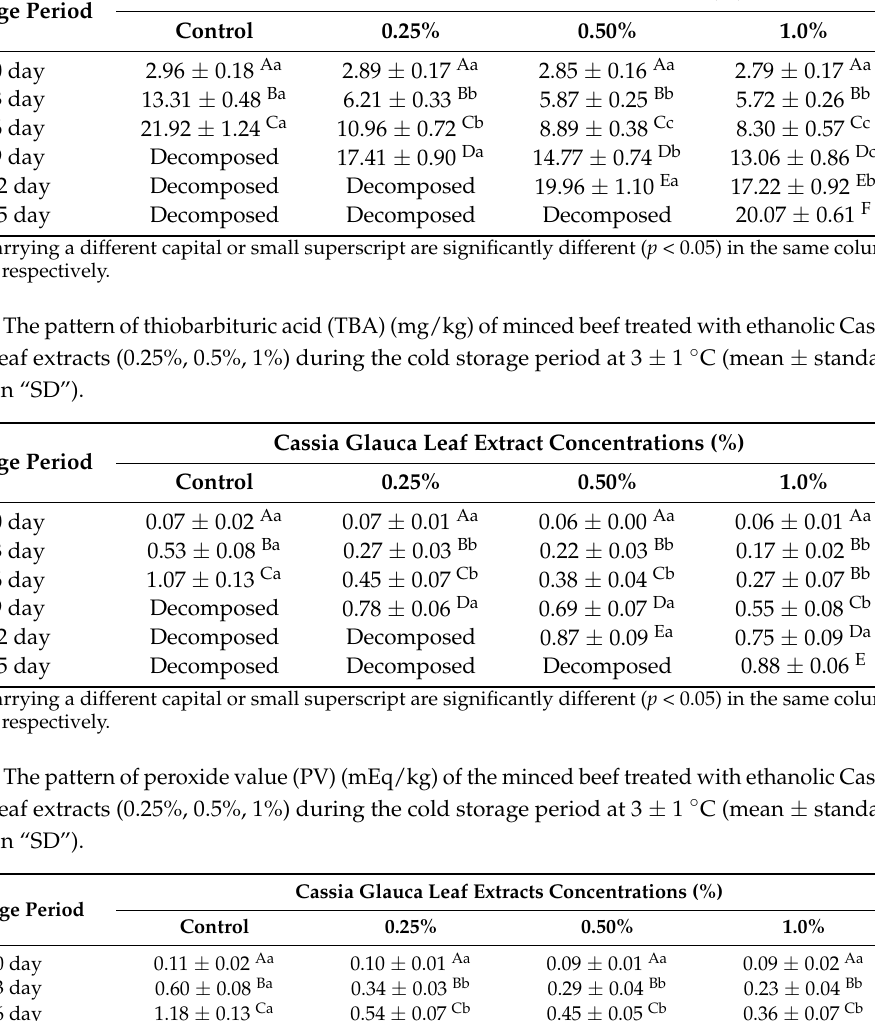
Means carrying a different capital or small superscript are significantly different ( p < 0.05) in the same column and row, respectively. Table 3. The pattern of the total volatile nitrogen (TVN) (mg%) of the minced beef treated with ethanolic Cassia glauca leaf extracts (0.25%, 0.5%, 1%) during the cold storage period at 3 ± 1 ◦ C (mean ± standard deviation “SD”).